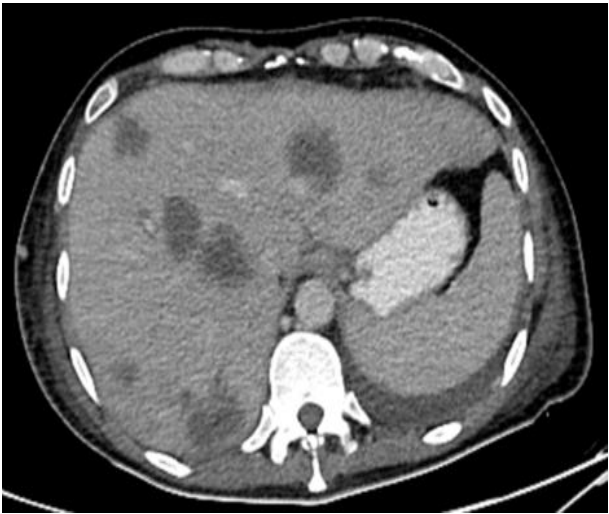
Figure 9. CT in the axial view of an abdominal window showing liver metastasis.